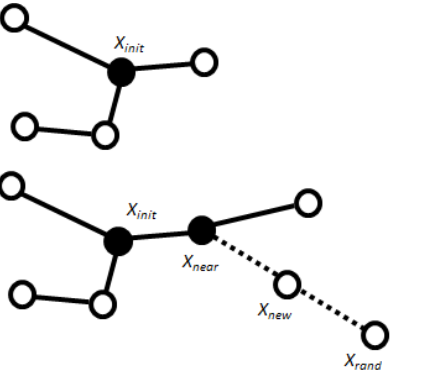
Figure 1. An illustration of the RRT